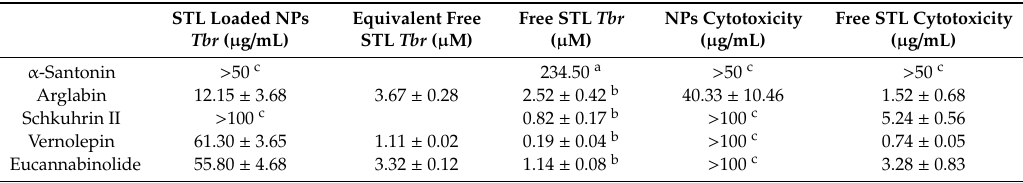
Table 2. Bioactivity data (IC 50 values) of the STL-loaded NPs, their equivalent free drug activity, and activity of naked STLs (mean ± S.D., n = 3 unless otherwise stated). STL Loaded NPs Tbr ( µ g /